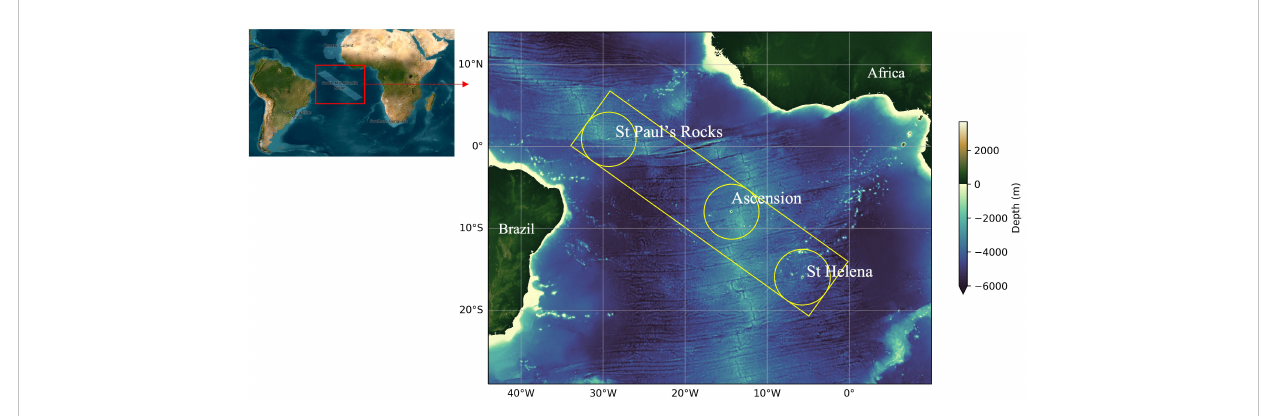
FIGURE 1 South Mid-Atlantic Ridge study area (yellow polygon). Circles indicate the EEZ of St Paul ’ s Rocks, Ascension Islands and St